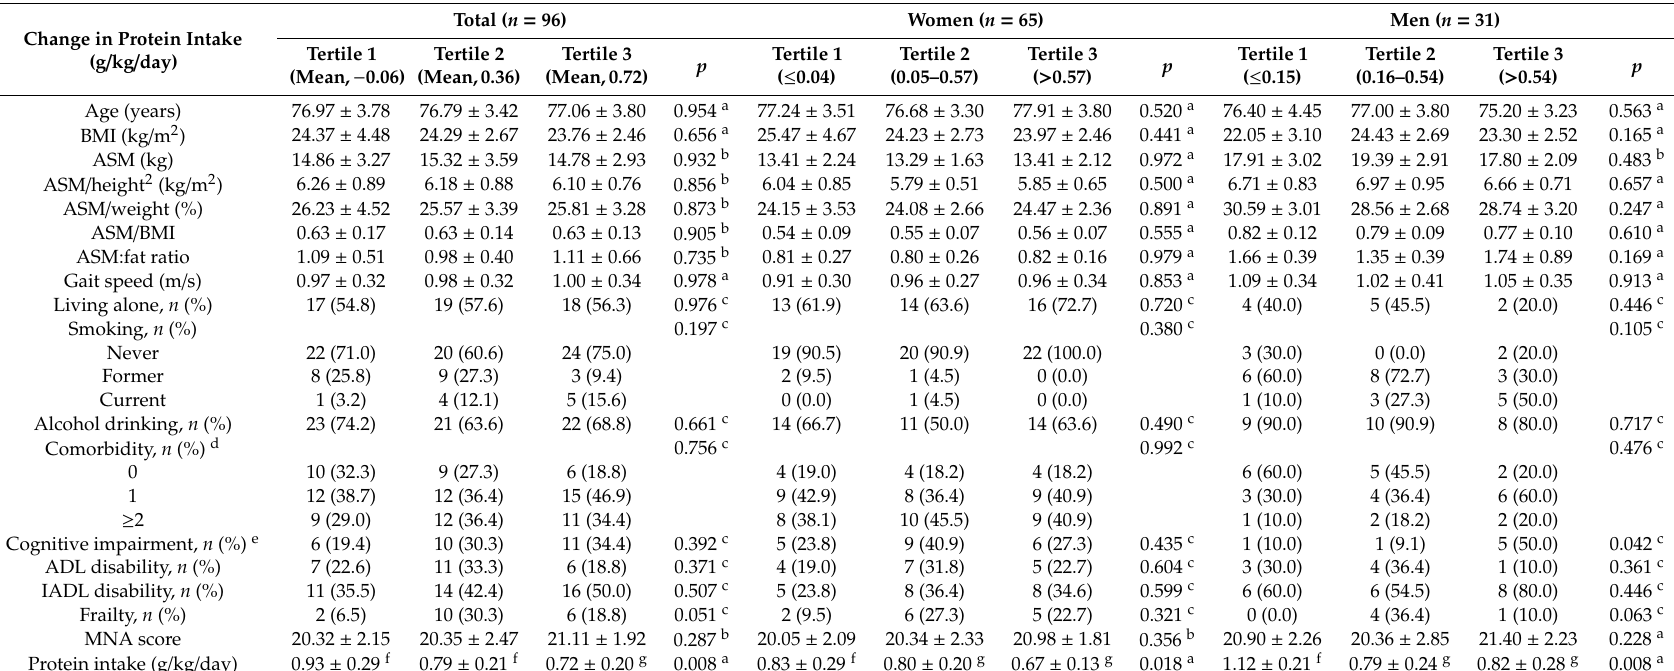
Table 1. Baseline characteristics according to sex-specific tertiles of change in protein